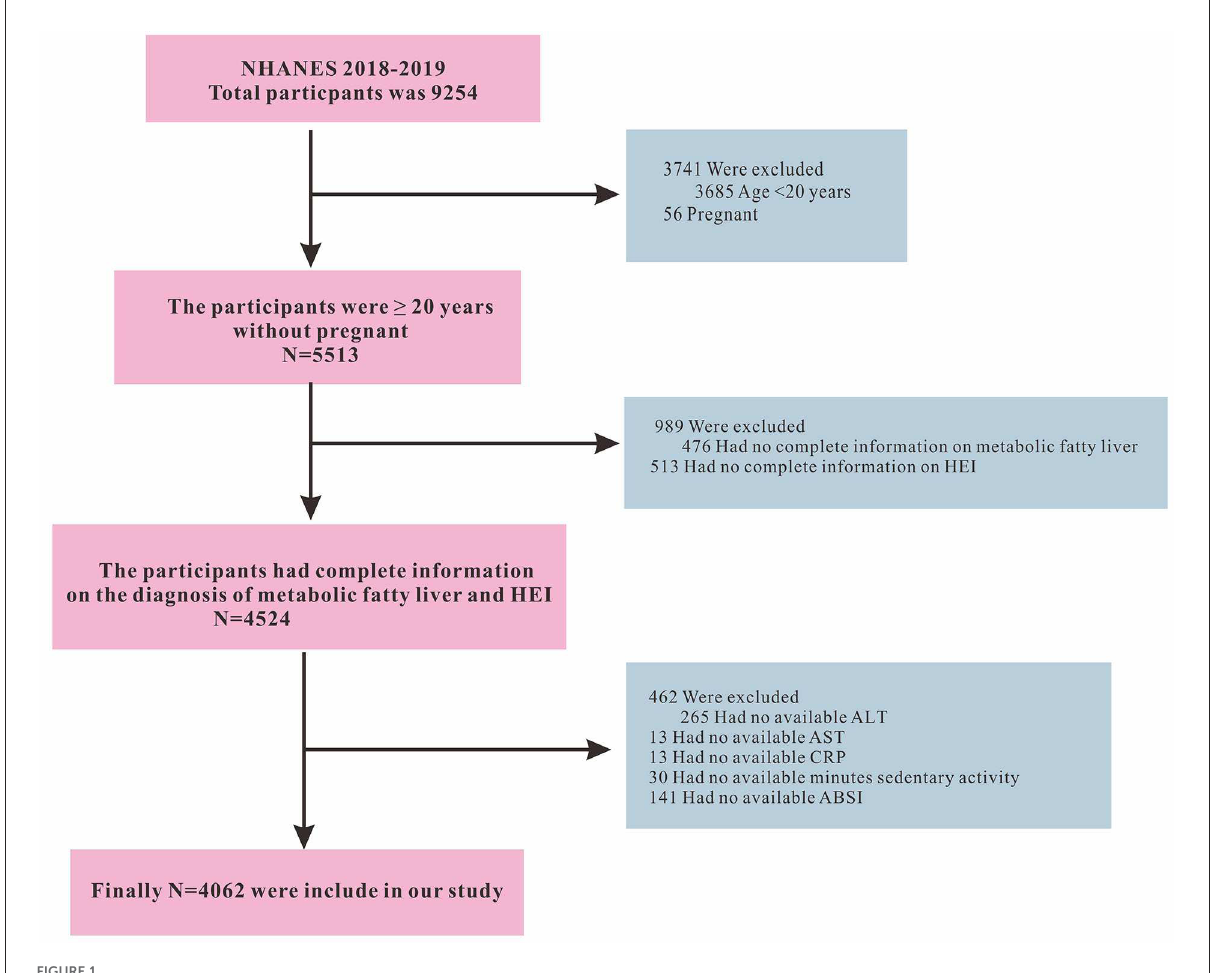
FIGURE1 Flowchart of study